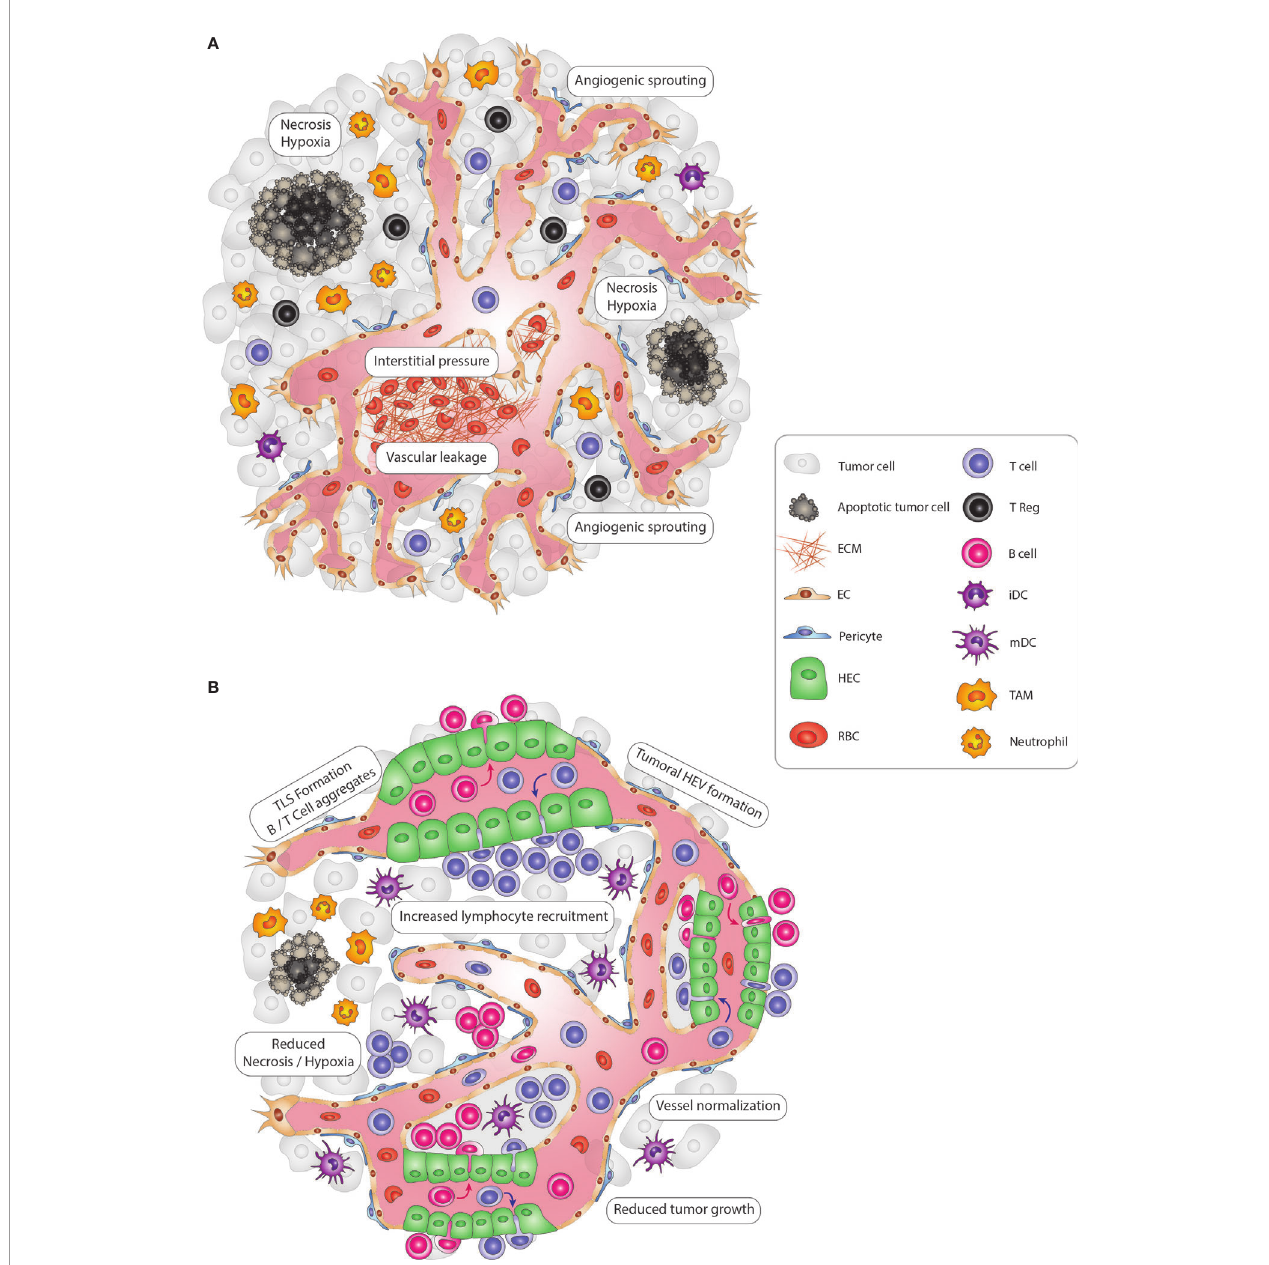
FIGURE 1 | Modulating vascular-immune interactions in solid tumors via TLS and HEV formation. (A) In solid tumors, vascular-immune interactions promote immunosuppression and neovascularization to allow the growth of cancer cells. Continuous angiogenic sprouting of ECs leads to an abnormal, less mature tumor vasculature with poor pericyte coverage leading to leakiness, dysfunctional blood fl ow and increased interstitial pressure which in turn promotes hypoxia and necrosis. Importantly, tumor blood vessels convey immunosuppressive signals that inhibit CD4 + and CD8 + lymphocyte in fi ltration, DC maturation and activate immunosuppressive regulatory T-cells (Tregs). Finally, innate immune cells, including TAMs and neutrophils, also suppress immunosurveillance and promote vascular remodeling. (B) Tumoral TLS and HEV induction promote anti-tumor immunity. In an immune-stimulatory setting, the tumor vasculature becomes transiently normalized with increased pericyte coverage, thus re-establishing blood fl ow and perfusion and reducing hypoxic and necrotic areas of the tumor. Due to the enhanced functionality, vessels are angiostatic and more prone to recruit immune cells which can lead to the formation of HEVs. Subsequently, HEV-containing TLSs form, with immune cell centers composed of CD4+ and CD8+ T, B lymphocytes, and mature DCs that promote an anti-tumor immune response. Tregs, TAMs, and neutrophils are less abundant, thus no longer exerting an immunosuppressive function. Altogether, re-awakening and boosting the immune system via TLS and HEV formation leads to reduced tumor cell growth and is ultimately bene fi cial for cancer progression. ECM, extra-cellular matrix; EC, endothelial cell; TLS, tertiary- lymphoid structure; HEV, high endothelial venule; HEC, high endothelial cell; iDC, immature dendritic cell; mDC, mature dendritic cell NK, Natural Killer cell; TAM, tumor-associated macrophage; RBC, red blood